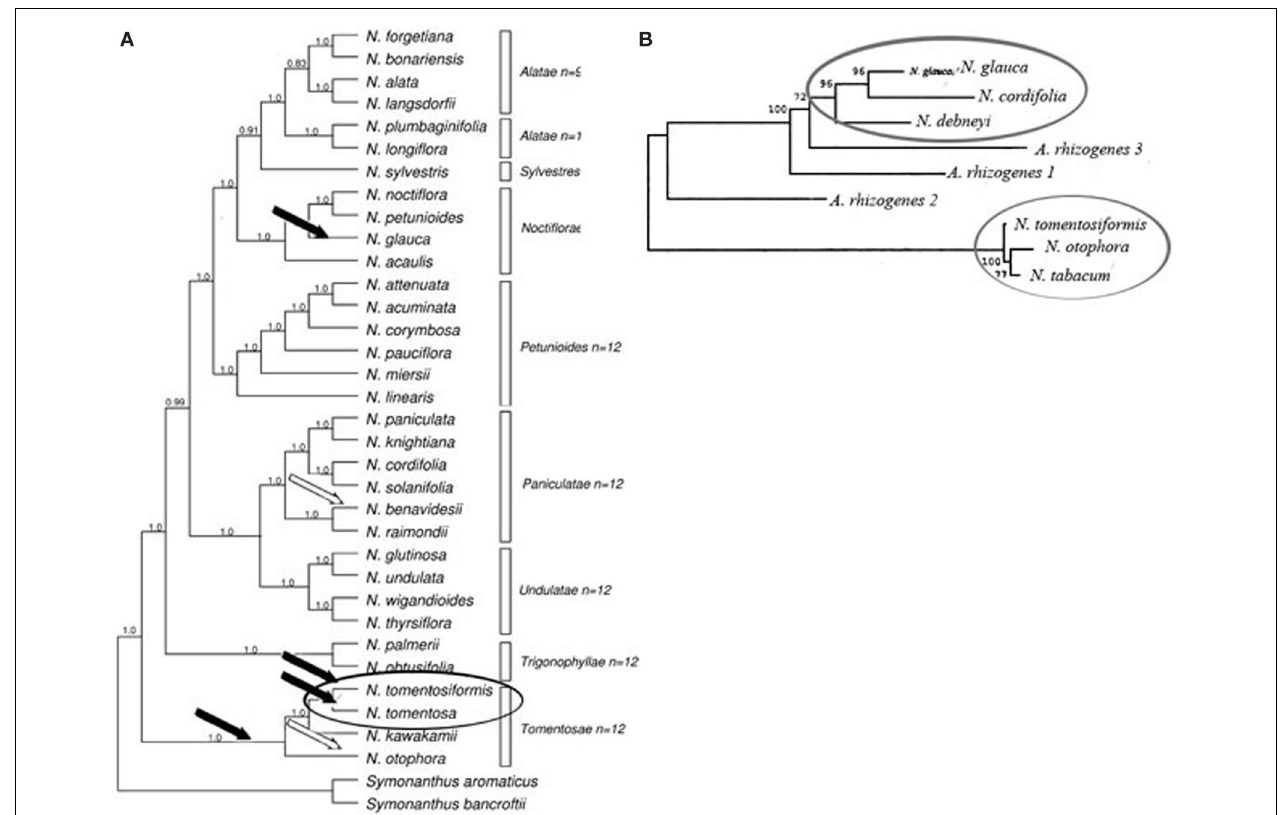
FIGURE 2 | Phylogenetic analysis of Nicotiana (Clarkson et al., 2004), using ITS and chloroplast sequences together with T-DNA marker. (A) Bayesian analysis of diploids only combined dataset (plastid and ITS). Consensus of 40,001 trees with posterior probabilities shown above branches. Bars indicate Nicotiana sections according to Knapp et al. (2004),